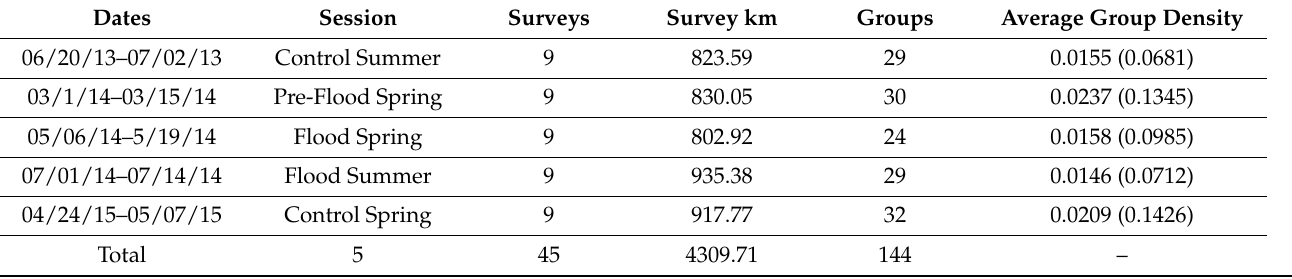
Table 1. Number of surveys, survey kilometers (km), dolphin groups, and average group density with standard deviation in parentheses for flood-impacted sessions, control sessions, and Pre-Flood Spring